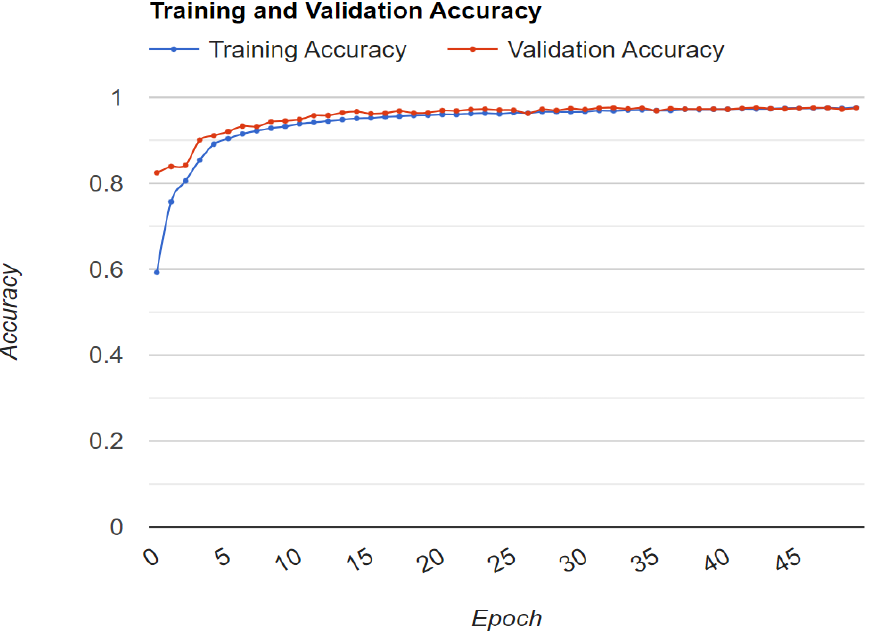
Figure 10. Training and validation accuracy trend.